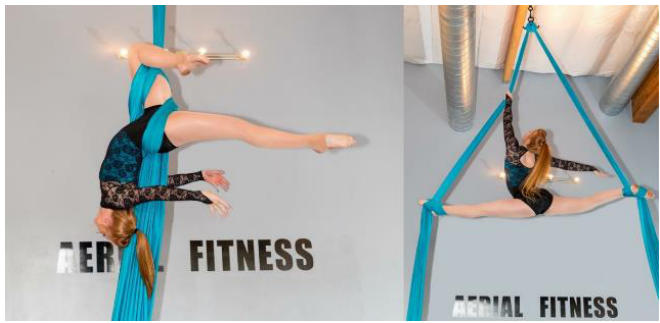
Figure 1. Aerial artist performing on the silks apparatus.